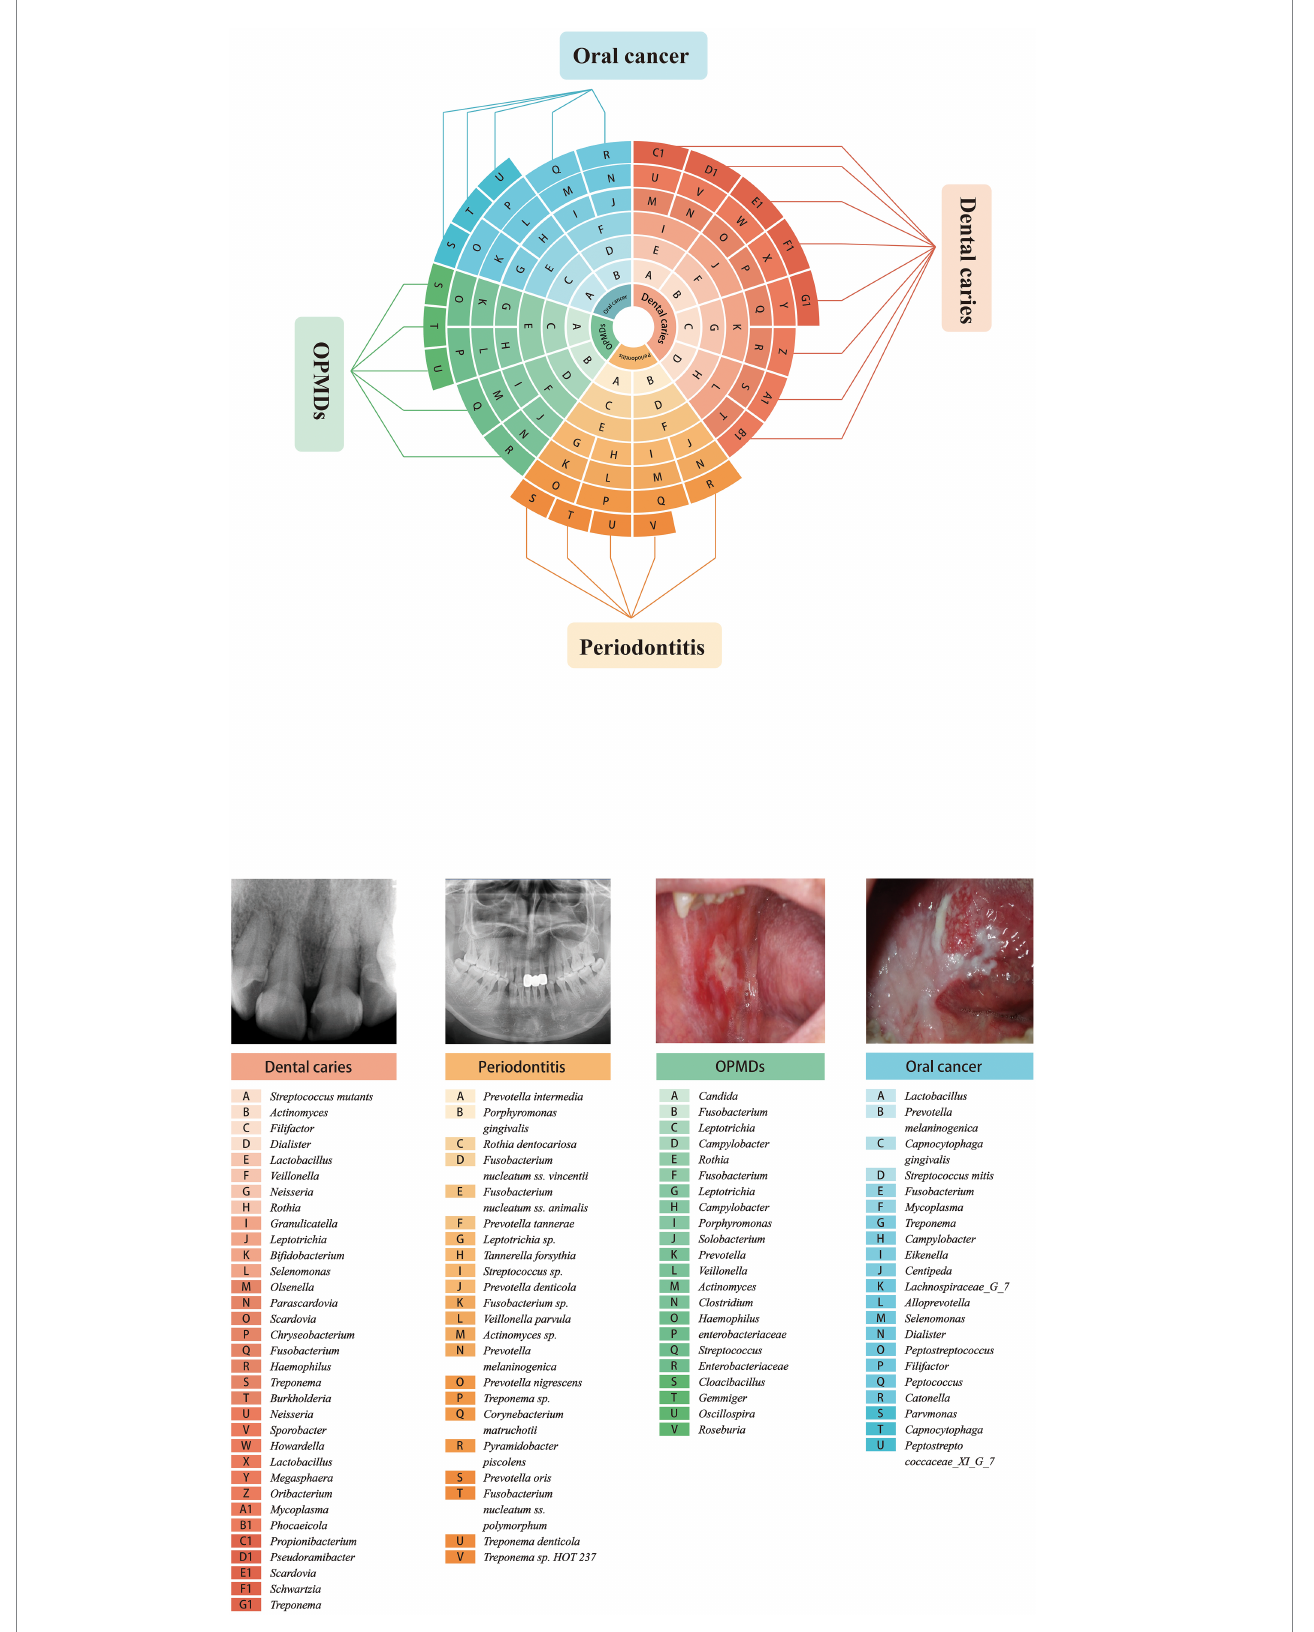
FIGURE 2 Oral species associated with major oral